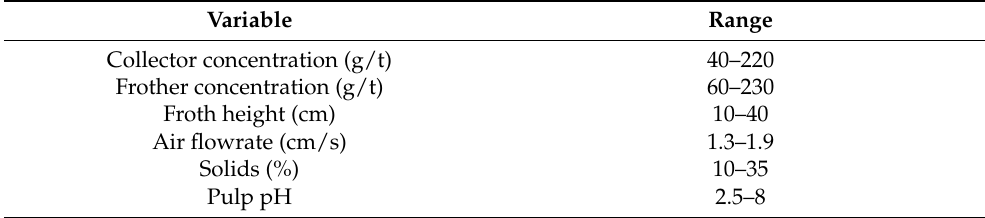
Table 1. Variables and levels used in column flotation experiments.